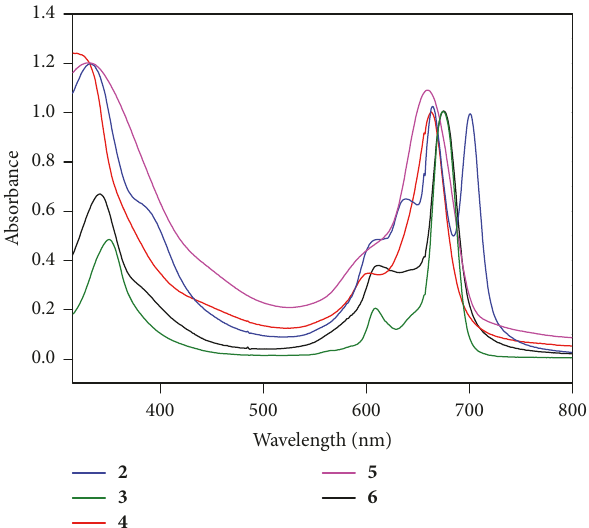
Figure 2: UV-Vis spectra of phthalocyanines ( 2–6 ).